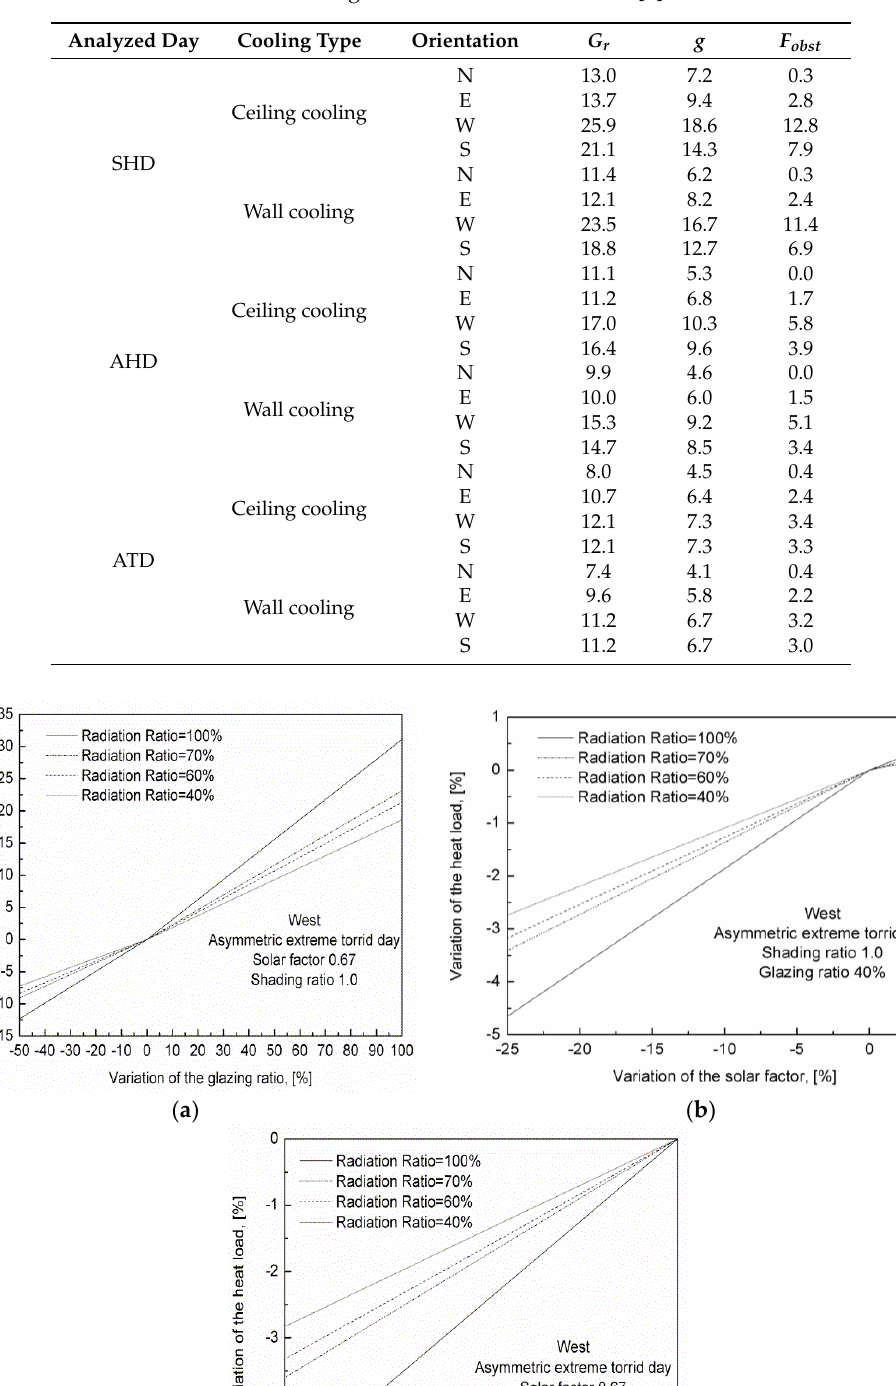
Table 7. Angle of the heat load variation [ ◦ ].